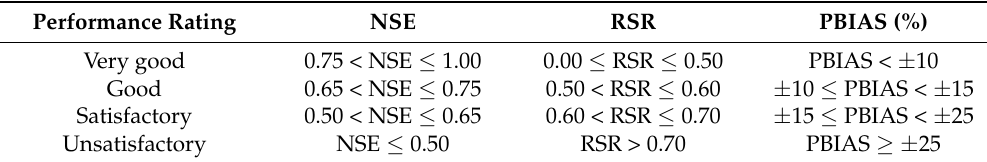
Table 1. Evaluation criteria for model performance